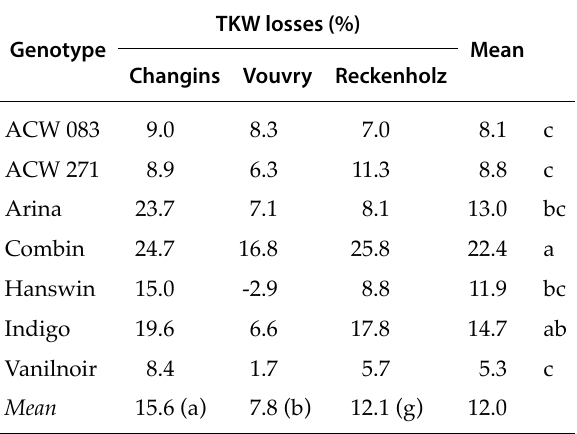
Figure 2. Mean Fusarium damaged kernel (FDK) ratios of three replicates, for seven wheat genotypes grown at three different field sites. Bars accompanied by the same letter are not statistically different ( P <0.05). Table 3. Means of Thousand Kernel Weights (TKW), losses (%) for all genotypes across at the three field sites (environ - ments). Data followed by the same letter are not signifi - cantly different ( P <0.05).